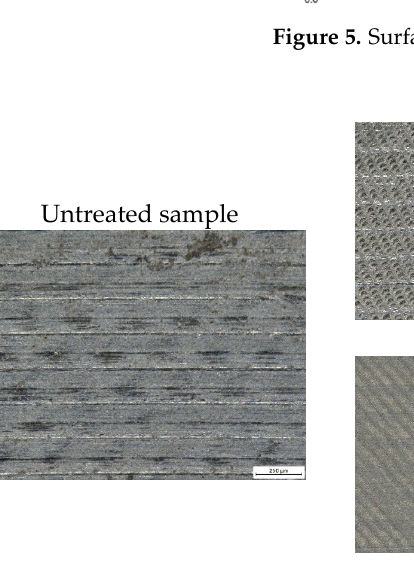
Figure 6. Surface morphology of di ff erent laser irradiations.